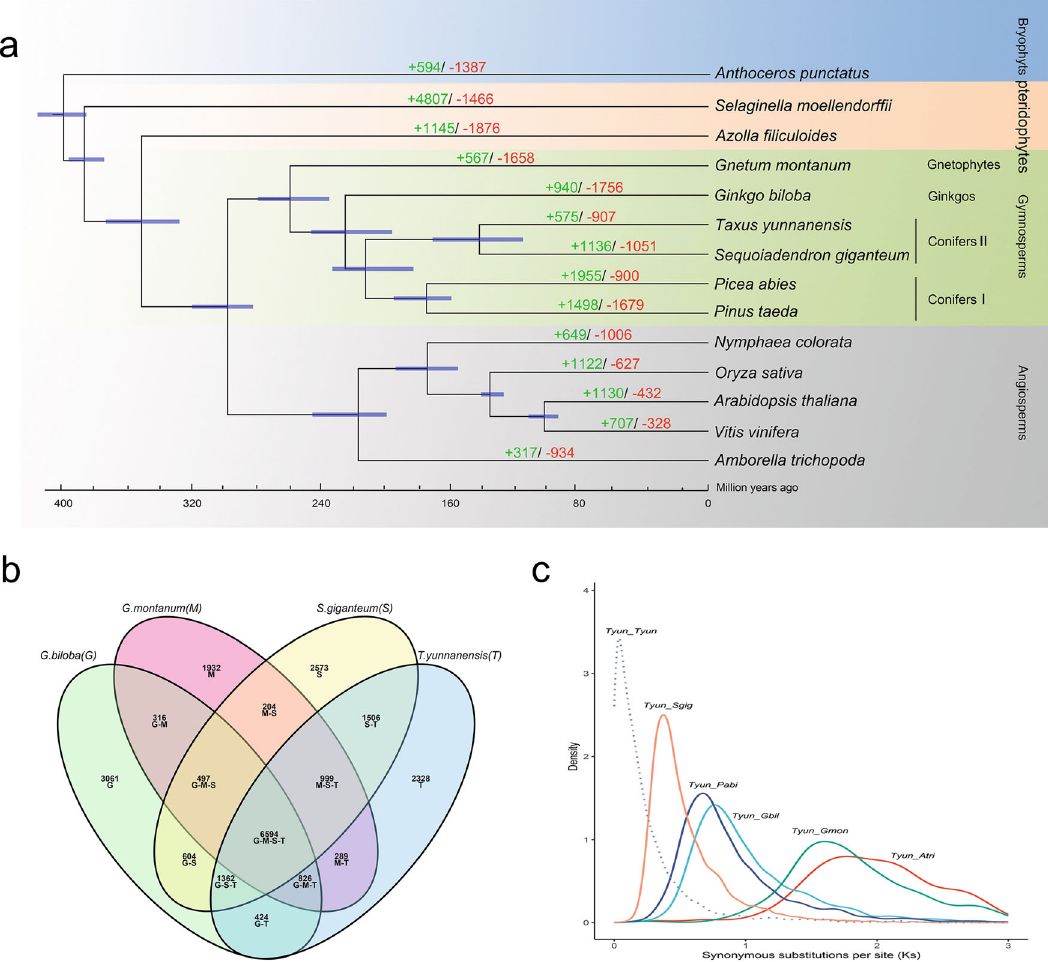
Fig. 2 Genome evolution of T. yunnanensis . a Inferred phylogenetic tree with 588 single-copy gene families in 14 plant species. Gene family expansions are indicated in green, and gene family contractions are indicated in red. Blue bars at nodes represent divergence times estimated by Maximum Likelihood (PAML). b Shared and unique gene families in four species. c Synonymous substitutions per synonymous site (Ks) distributions of orthologous (and paralogous) genes between T. yunnanensis and G. montanum , G. biloba , P. abies , S. giganteum and A. trichopoda